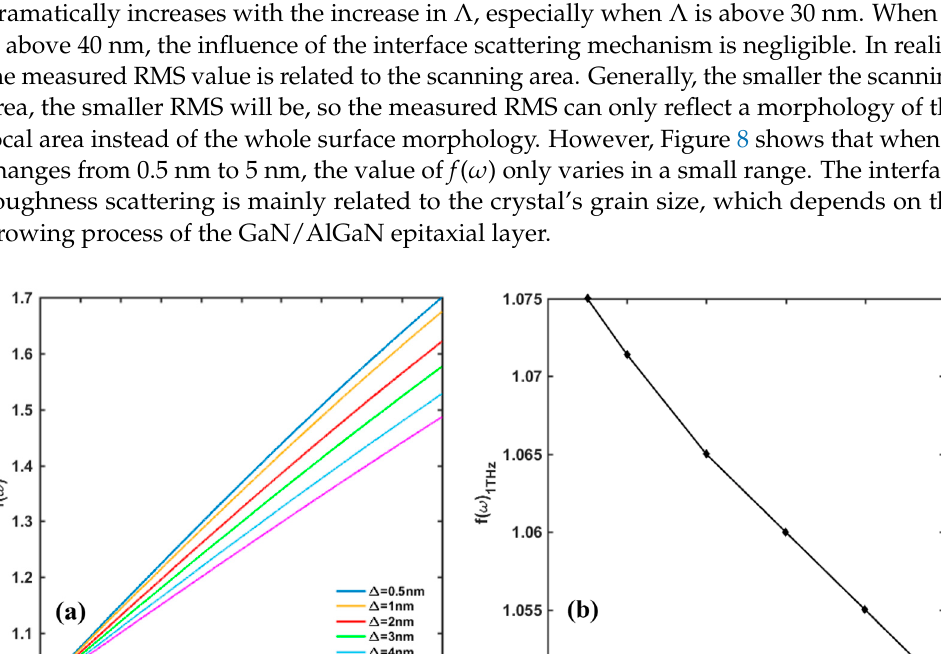
Figure 9. ( a ) Variation in f( ω ) with lateral correlation length Λ in frequency range of 0.1–10 THz. ( b ) Value of f( ω ) at 1 THz incident frequency with change in Λ . Other parameters are taken as n s = 10 13 /cm 2 , N dis = 10 10 /cm 2 , and Δ = 1 nm. 3.2. Model Validation Next, we use the experimental results [14,28] of our two prepared GaN/AlGaN HEMT terahertz detector samples to verify the accuracy of our proposed model. It should be clarified that our model can only predict the response voltage instead of the responsiv- ity and noise equivalent power (NEP) of the detector. This is because the power and ef- fective area of the incident THz radiation have to be calibrated in the experiment, and the minimum background noise is estimated by the standard quantum limit (SQL), which is out of the scope of this work. Here, we compared the measured response voltage of the samples with the solution of the model. The response voltage with the change in gate– source voltage V gs for two samples was measured at the incident THz frequencies of 0.1 THz and 0.315 THz. To compare the experimental and calculation results of our proposed model under the same conditions, the variable s related to V gs is replaced by s = ( eU 0 / m ) 1/2 in Equations (6)–(10). The samples’ material parameters are listed in Table 2. Figure 10 shows a comparison between the experimental and calculated results of the response volt- age for the two samples. When the overdrive voltage U 0 is close to zero, the calculated response voltage is extremely high since the model has a singular point with infinite value